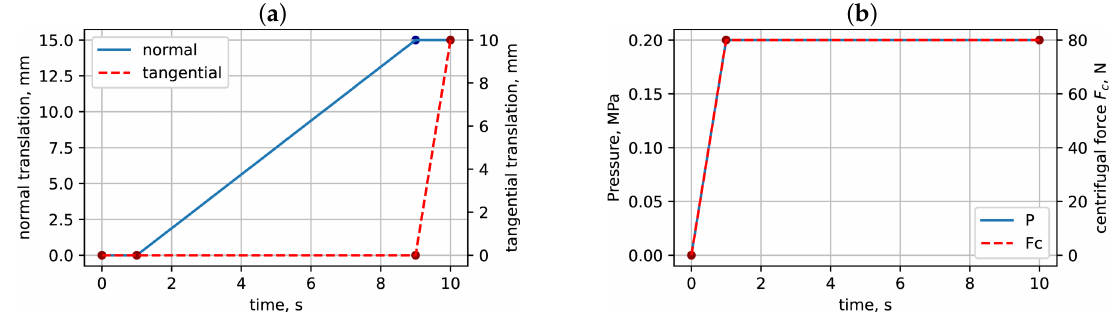
Figure 1. Model time steps: ( a ) movement of road surface and ( b ) pressure in tyre vs time.